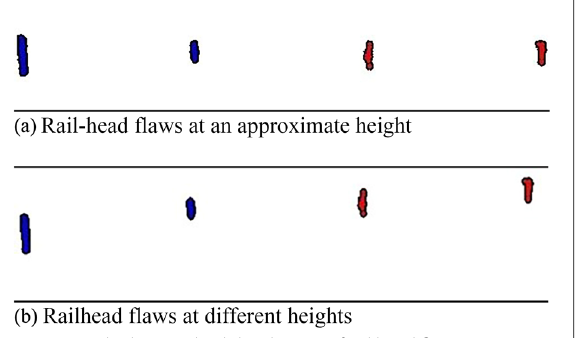
Figure 10 The longitudinal distribution of rail head